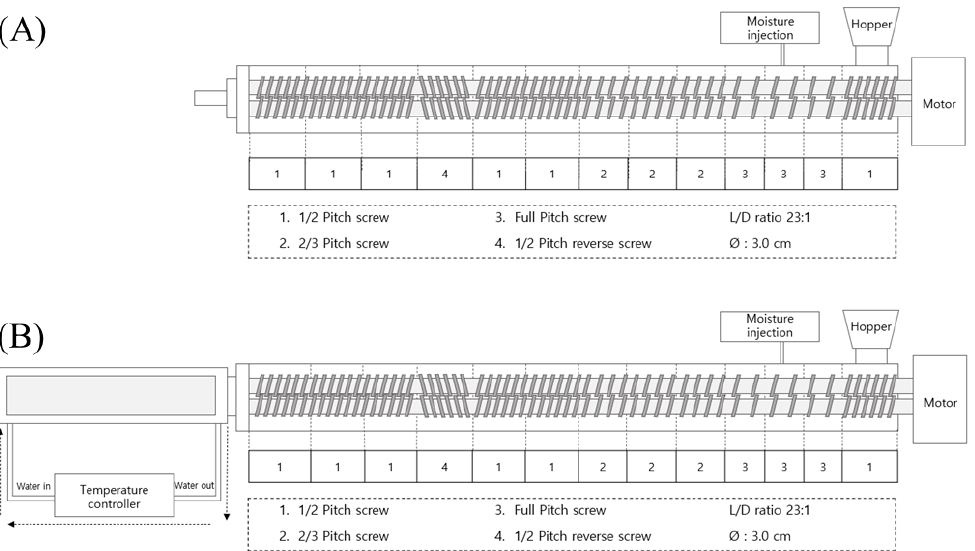
Figure 1. Low- ( A ) and high-moisture ( B ) extrusion processes and screw configurations used in this experiment this